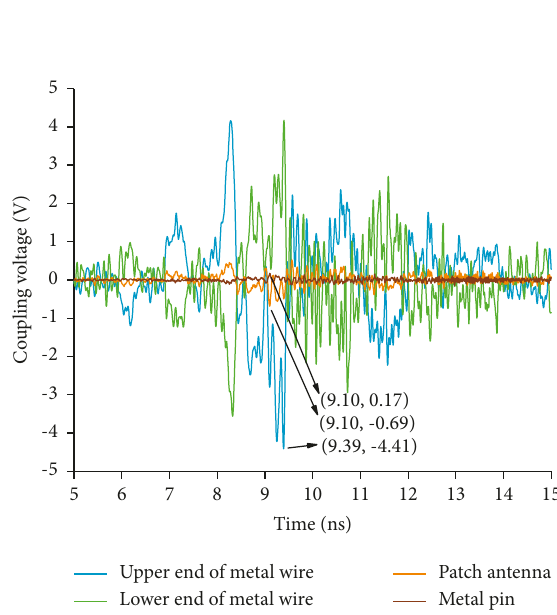
Figure 14: Circuit model.